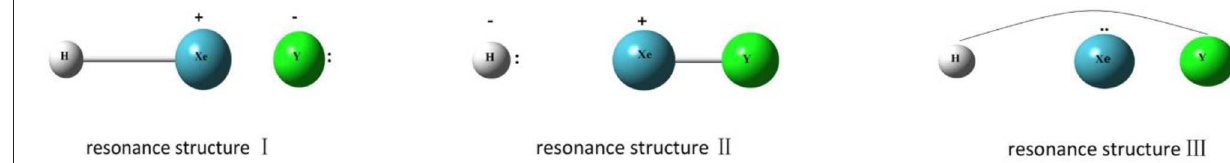
FIGURE 2 | Three resonance structures for HXeY. A pair of dots represents a lone pair.